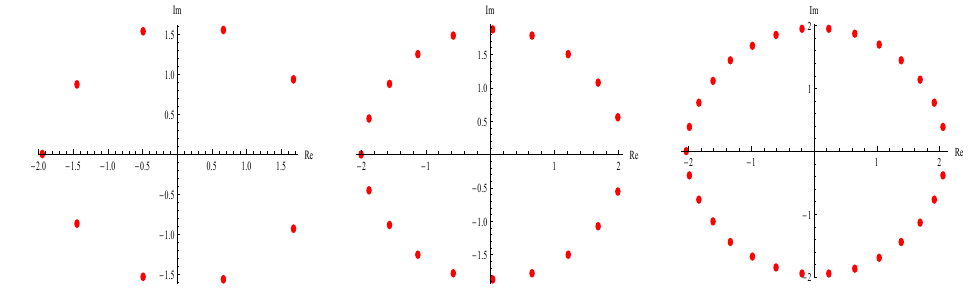
Figure 5. Approximate roots of C B n ,0.1 ( x ,5 ) for n =